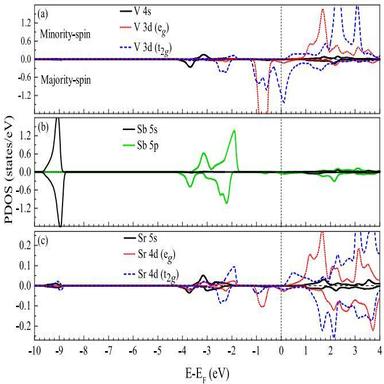
Spin-resolved site and orbital projected density of states of HH-VSbSr in the bphase.